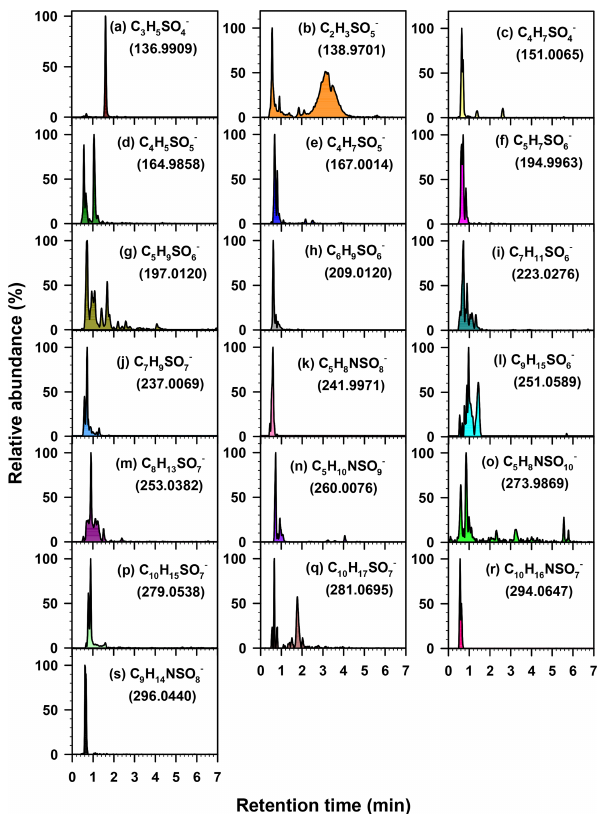
Figure 3. Extracted chromatograms of 19 major organosulfate species obtained from a PM 2 . 5 sample collected in Atlanta using HILIC-ToF. Extracted chromatograms of the remaining 13 major organosulfate species are shown in Hettiyadura et al. (2017) for a PM 2 . 5 sample collected in Centreville. MS data, structures, and VOC precursors of these organosulfates are given in Table